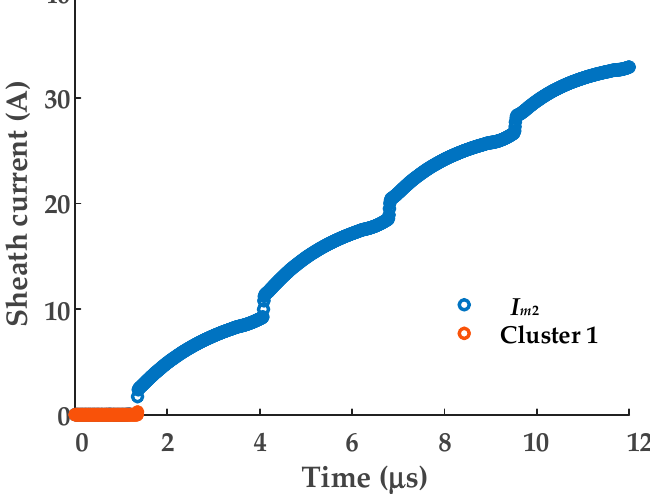
Figure 21. The scatter diagram of the sheath current I m 2 .